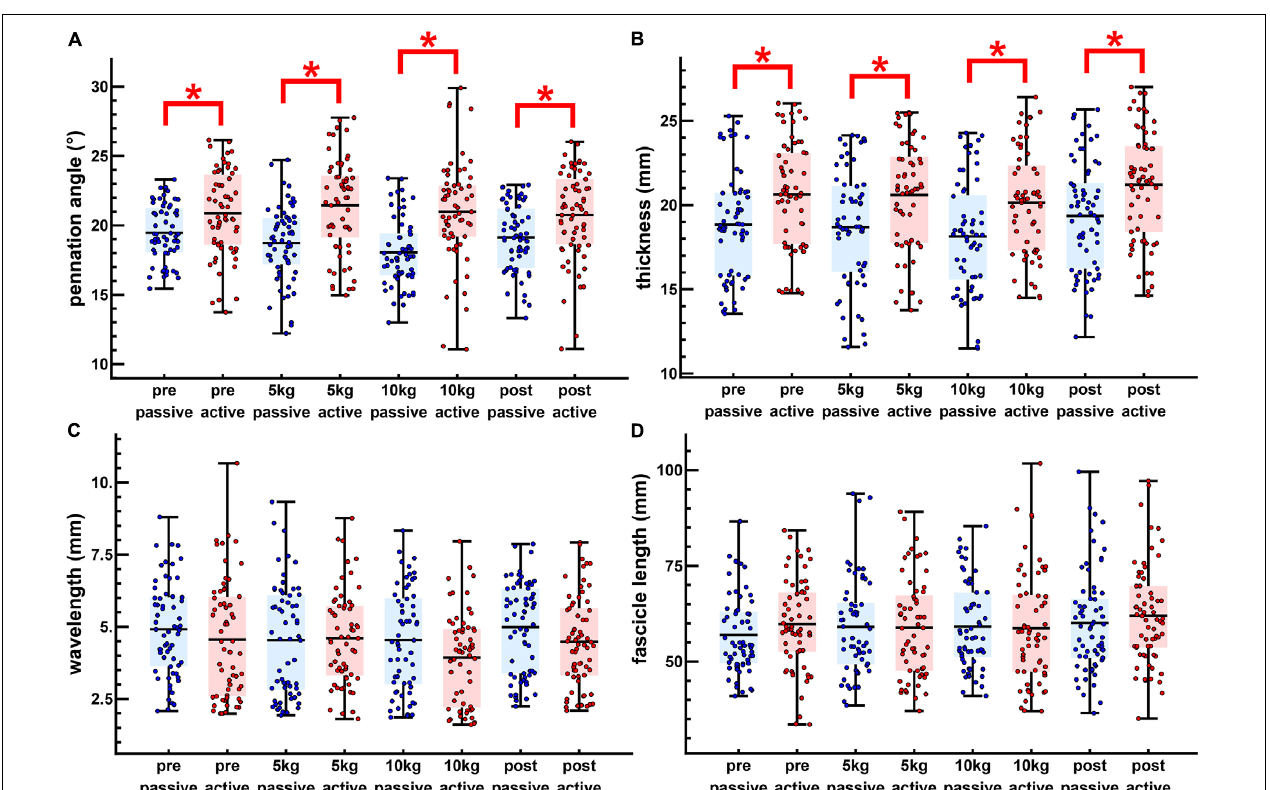
FIGURE 4 | The passive loaded and peak active loaded values for all twitches. Passive (blue) and active (red) values are shown for the pennation angle (A) , muscle thickness (B) , transverse wavelength (C) , and fascicle length (D) . The dots show individual twitches with the boxes showing the mean and span from the 0.25 to the 0.75 quantile. Significant differences are shown between passive and active states ( ∗ p <